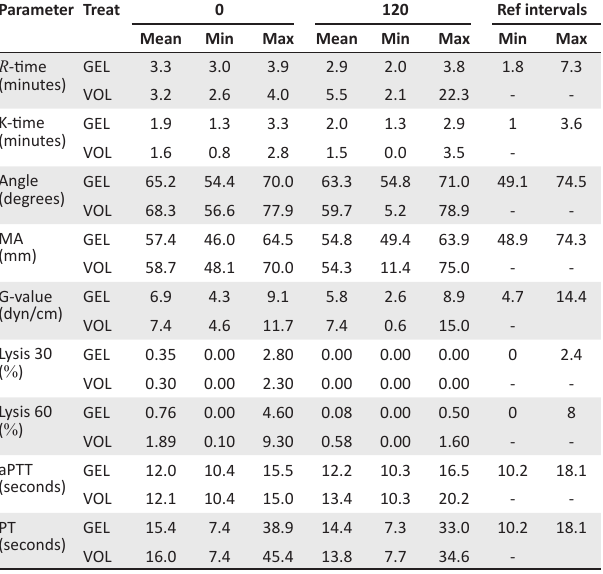
TABLE 4: Thromoboelastography and coagulation indicators of eight healthy beagle dogs undergoing colloid fluid infusion for 120 min with 10 mL/kg/h of Gelofusine ® (succinylated gelatin) or Voluven ® (tetrastarch 130/0.4). Parameter Treat 0